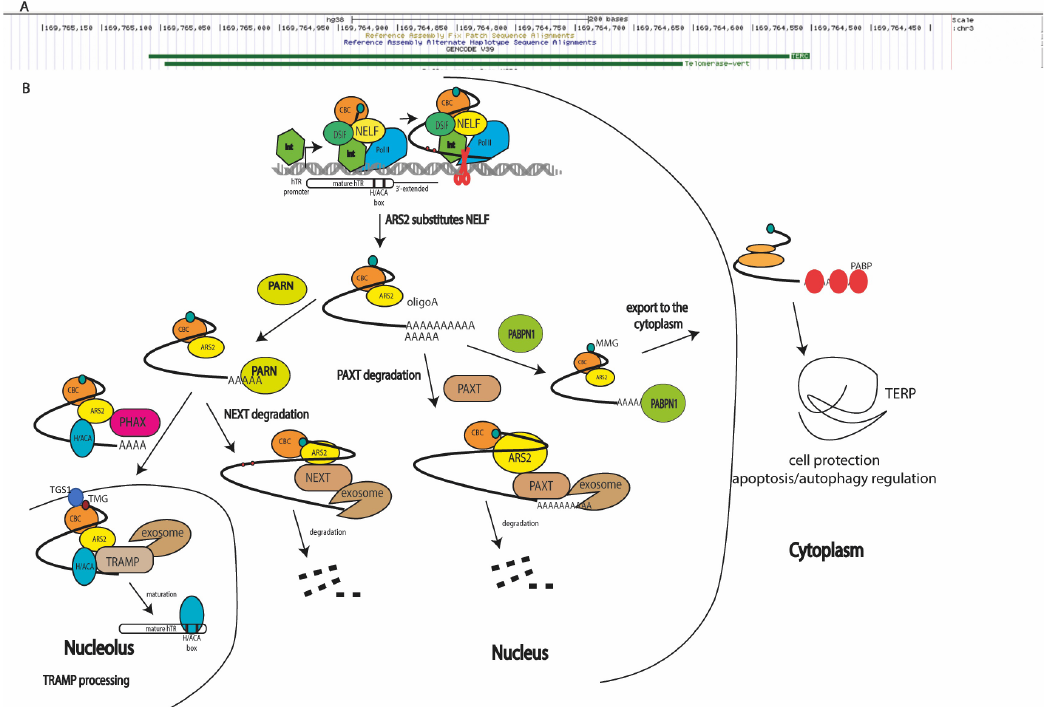
Figure 1. Biogenesis pathways of human telomerase RNA transcripts (hTERC): ( A ) two isoforms of hTERC presented in cells (https://genome.ucsc.edu accessed on 9 June 2022); ( B ) scheme illustrating biogenesis mechanisms of products transcribed from hTERC gene. Integrator (Int), DSIF, NELF, and cap-binding complex (CBC) assist RNA polymerase II to synthesize the primary hTERC transcript [14,27]. ARS2 substitutes NELF and coordinates the distinct, mutually exclusive complex assembly to process the primary transcript [29–32]. During processing, monomethylated (MMG), polyadenylated hTERP mRNA is protected by PABPN1, which is substituted by PABP and exported to the cytoplasm, where it is translated [18,27]. Oligoadenylated hTERC transcripts may be degraded by RNA exosomes attracted by the PAXT complex [27], or may be trimmed by PARN followed by degradation through NEXT-attracted RNA-exosomes [21], or transported by PHAX to the nucleo- lus [28] where it is hypermethylated (TMG) by TGS1 [16] and matured by TRAMP-mediated RNA exosome trimming [15,18] for assembly into the active telomerase